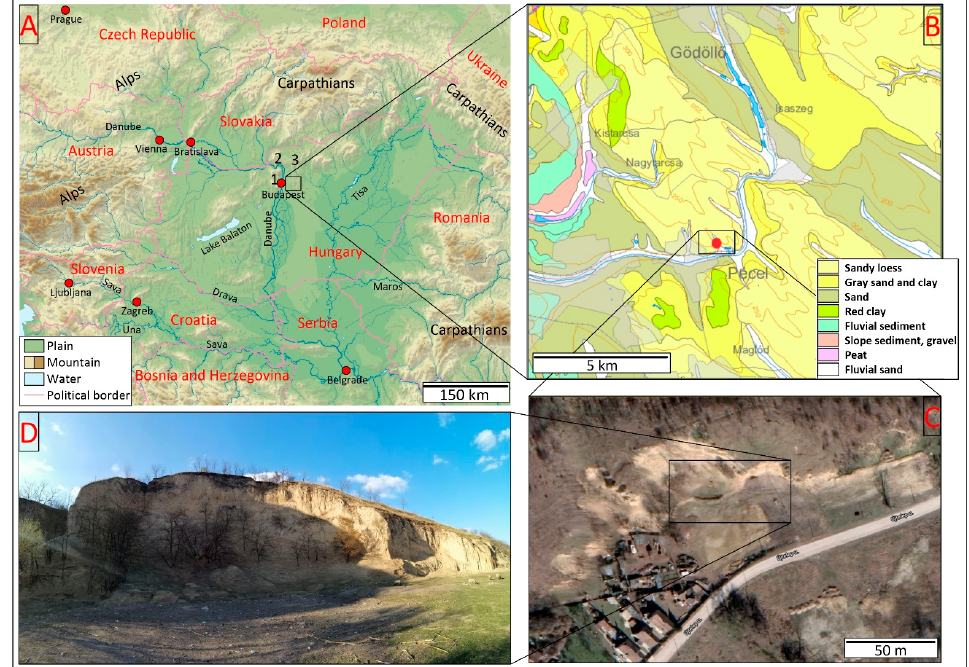
Figure 1. Location of the loess-paleosol sequence of Pécel in the Carpathian Basin (( A ) figure: 1. Buda Thermal Karst, 2. Börzsöny, 3. Cserhát [40], ( B ) figure: surface formations [41], ( C ) figure: orthophotomap [42], ( D ) figure: selfmade site photo).